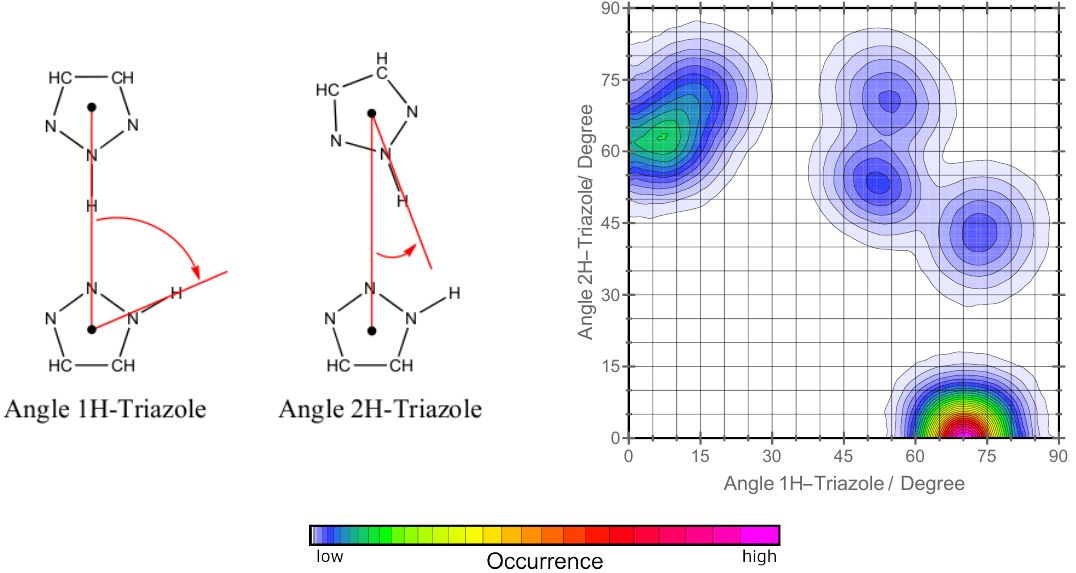
Figure 7. On the left side, the two angle criteria for the calculated combined distribution function are defined. On the right side, the calculated combined distribution function for the orthorhombic phase at 280K is shown. Qualitatively, the monoclinic phase at 269K shows the same behavior and was there not shown here. In the graph two predominant angle patterns within the crystals can be seen. The transition angles are seen with low occurrence. Lowermost the color scheme for the qualitative probability of occurrence is